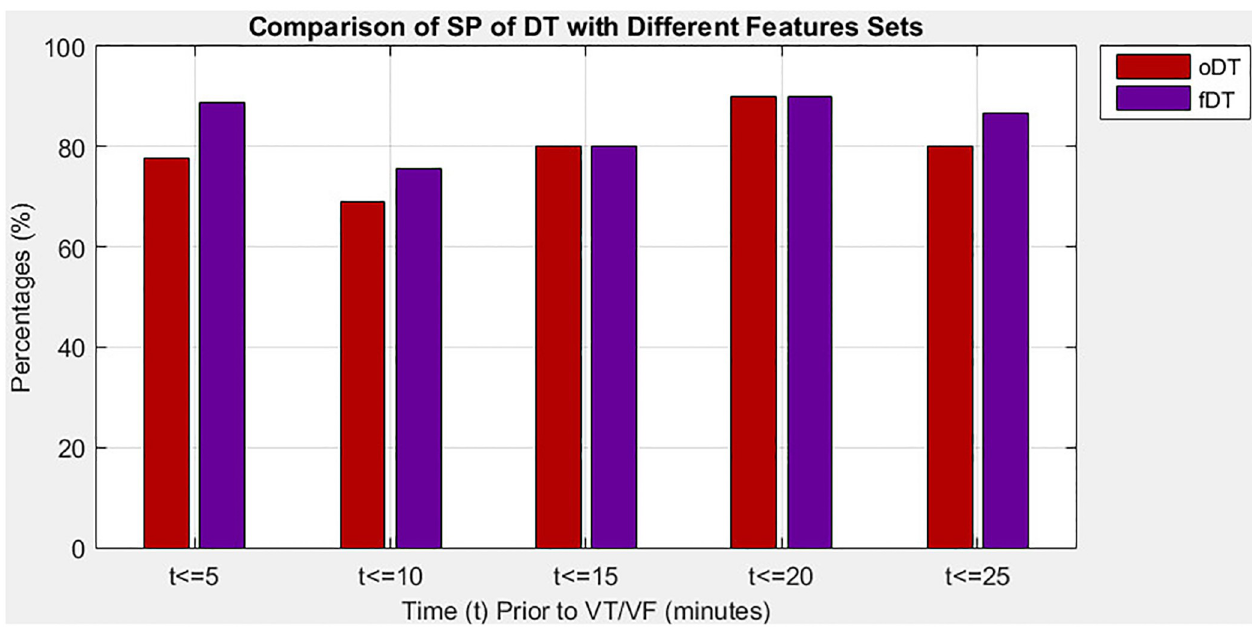
Fig 4. Comparison of SP for DT with different sizes of feature